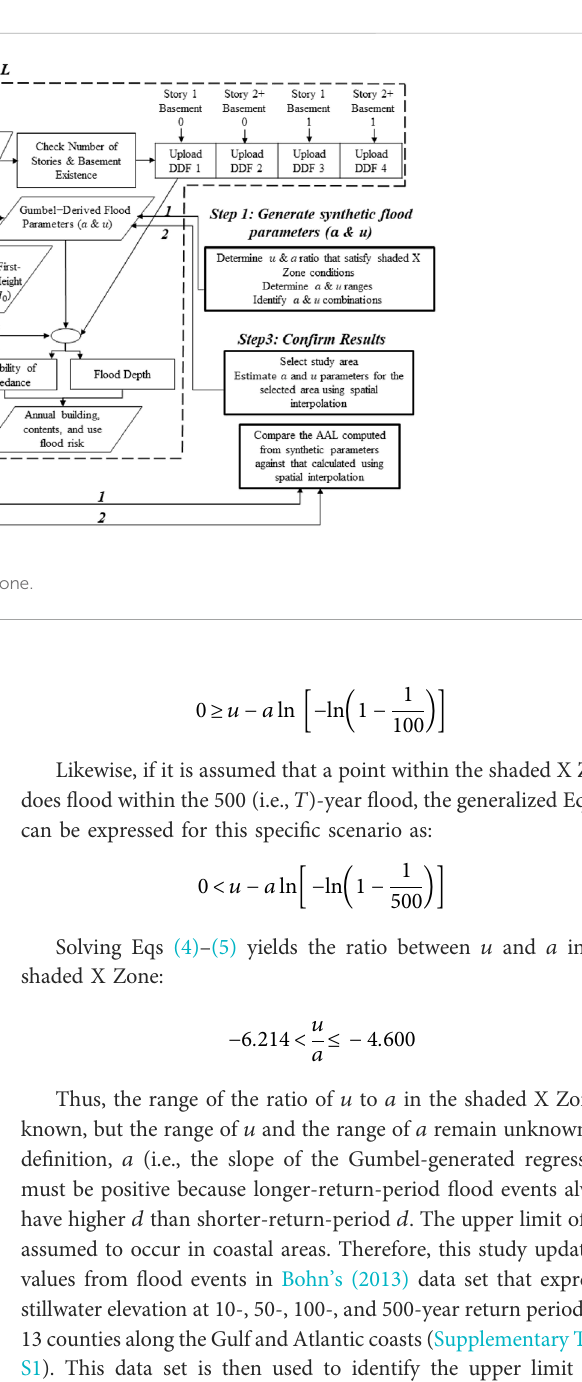
FIGURE 2 Case study areas in Santa Clarita, California, and Jefferson Parish, Louisiana, highlighting thehomessituated inthe Special Flood Hazard Area (SFHA) and shaded X